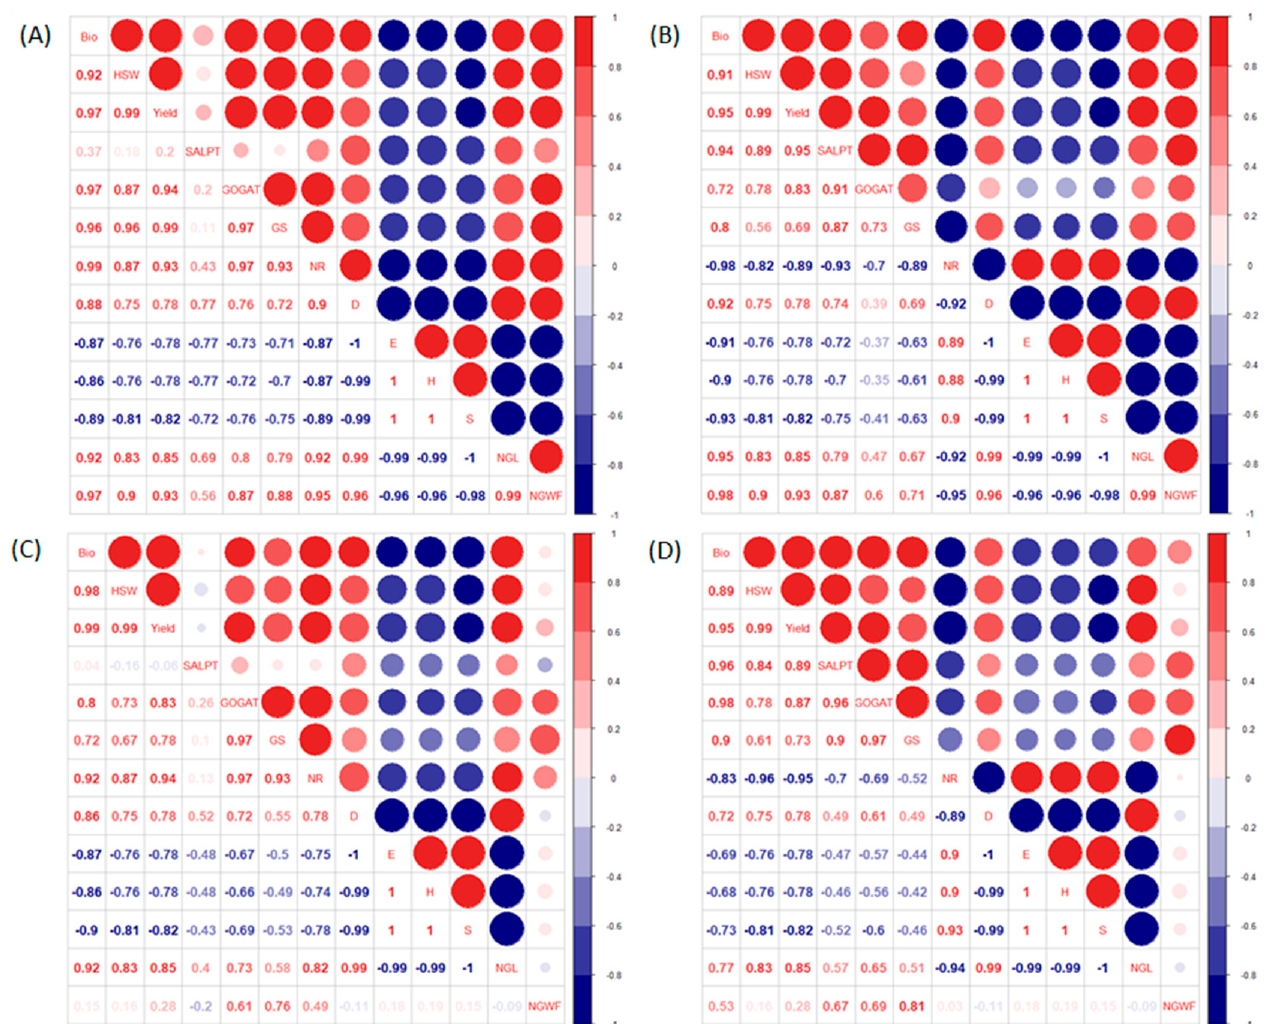
Figure 5. Correlation among biomass, 100-seed weight, yield and enzyme activities related to ni- trogen metabolism and the insect diversity index of soybean based on averages from 2018 to 2019 (Note: ( A ) normal fertilizer, R2; ( B ) normal fertilizer, R5; ( C ) reduced fertilizer, R2; ( D ) reduced fertilizer, R5; Bio: biomass; HSW: 100-seed weight; SALPT: soil alkaline protease; GOGAT: gluta- mine oxoglutarate aminotransferase; GS: glutamate synthetase; NR: nitrate reductase; D : Simpson dominance index; E : Pielou evenness index; H : Shannon–Wiener diversity index; S : species number of insect; NGL: number of green leafhoppers; NGWF: number of greenhouse whiteflies; brick red represents a positive correlation; blue represents a negative correlation; the darker the color, the more significant the correlation). The degree of freedom for correlation analysis is 7, and | r | > 0.66 is considered significant.